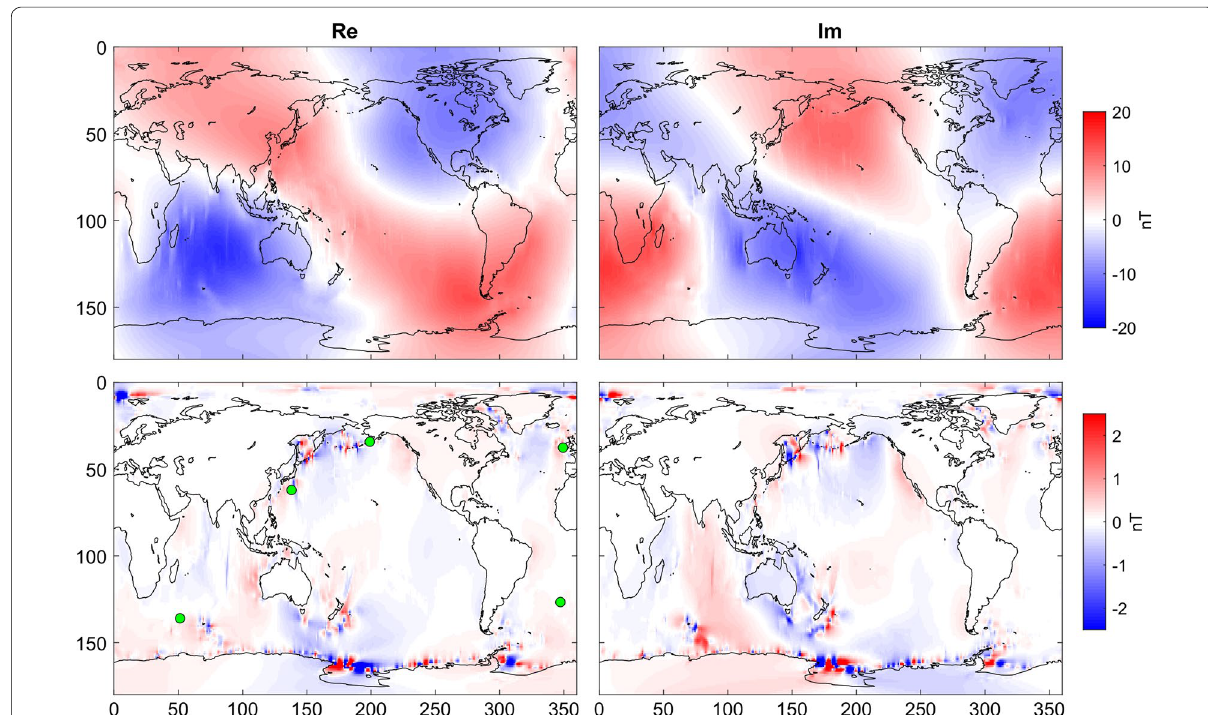
Fig. 13 Modeled Y component at a period of 24 h at the sea level. Top and bottom are the Sq and tidal field, respectively. Left and right are the real and imaginary parts, respectively. Note the different scales for top and bottom plots